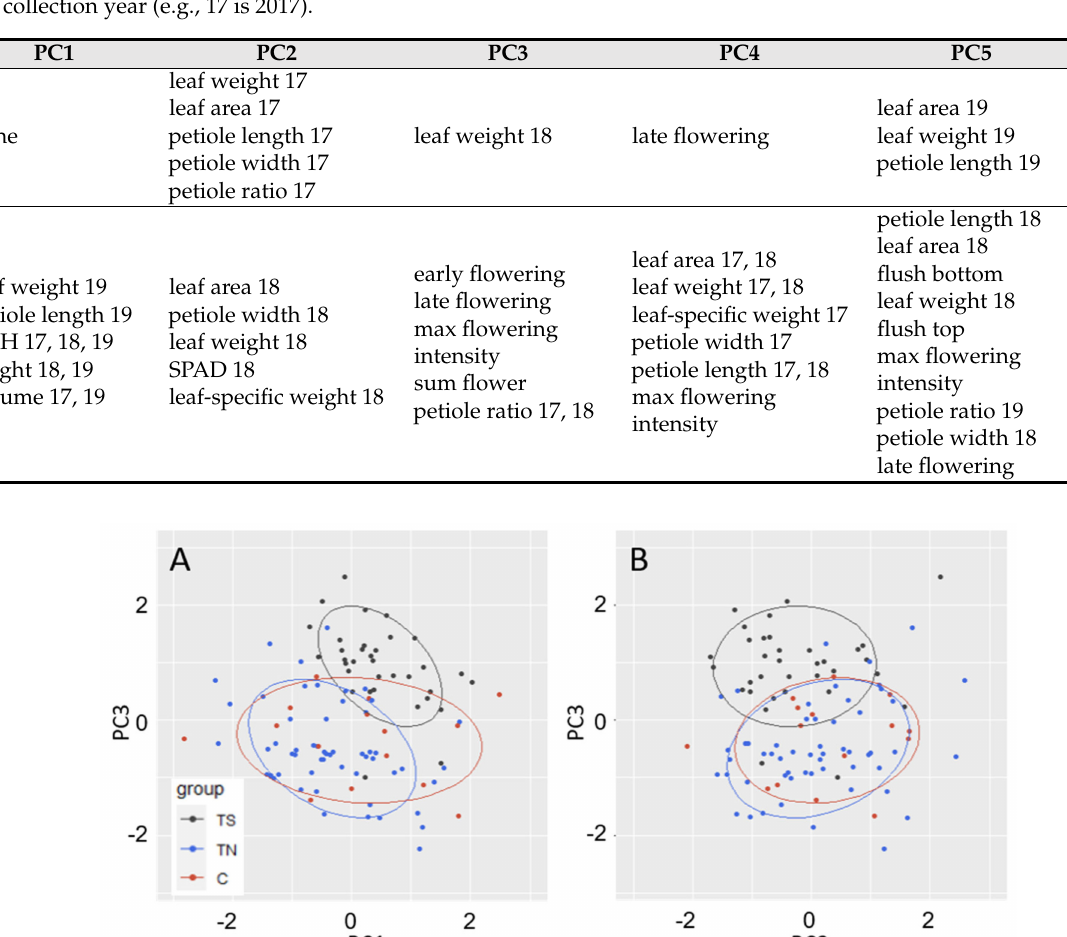
Table 2. Summary of traits with large PC loadings. Traits shown are those with absolute values of 0.2 or greater for PC 1-5. Positive associates are those traits with a positive loading value, negative associations are those with a negative loading value. For simplicity, significant traits of the same type from different years have been combined into one cell, where numbers indicate collection year (e.g., 17 is 2017).